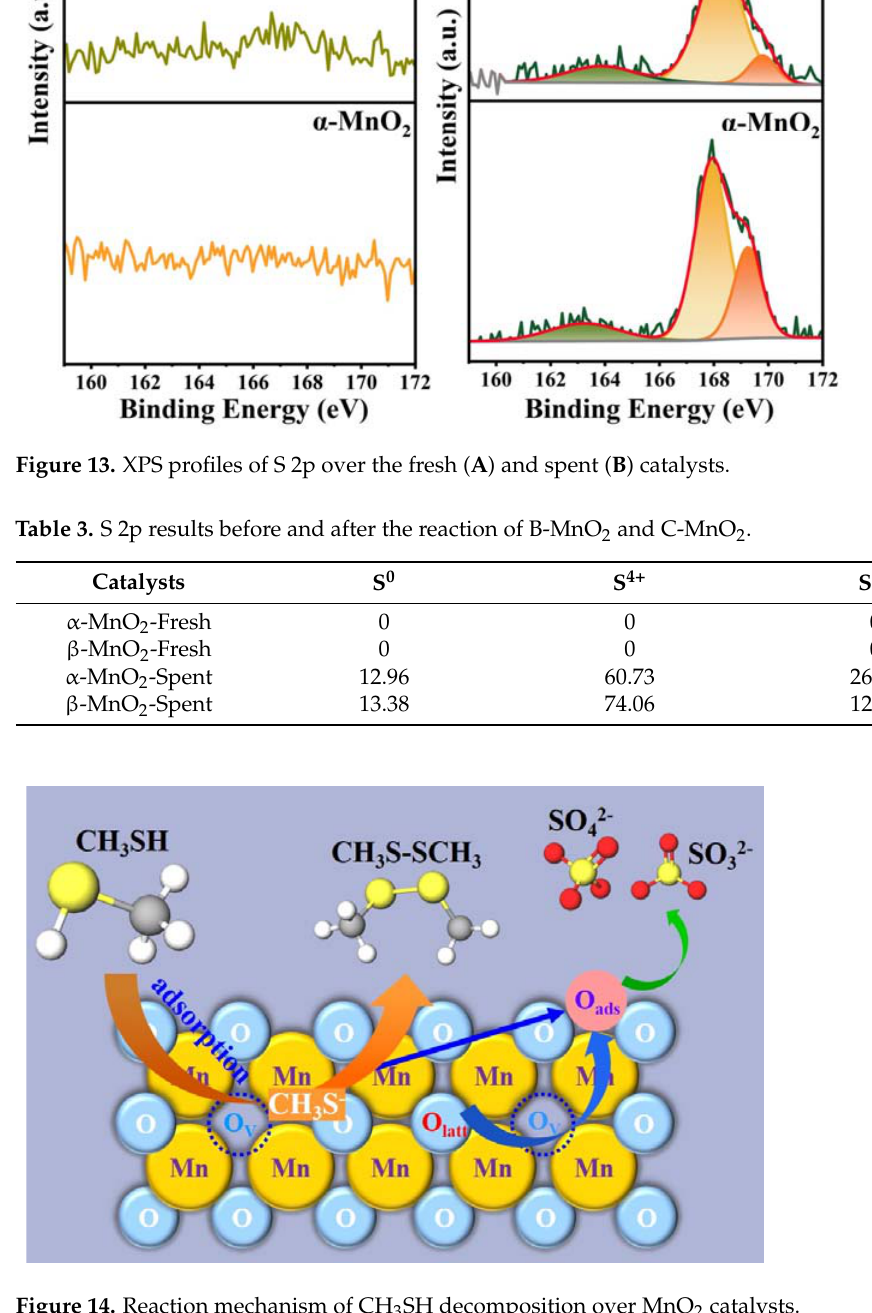
Figure 13. XPS profiles of S 2p over the fresh ( A ) and spent ( B ) catalysts. Table 3. S 2p results before and after the reaction of B-MnO 2 and C-MnO 2 .